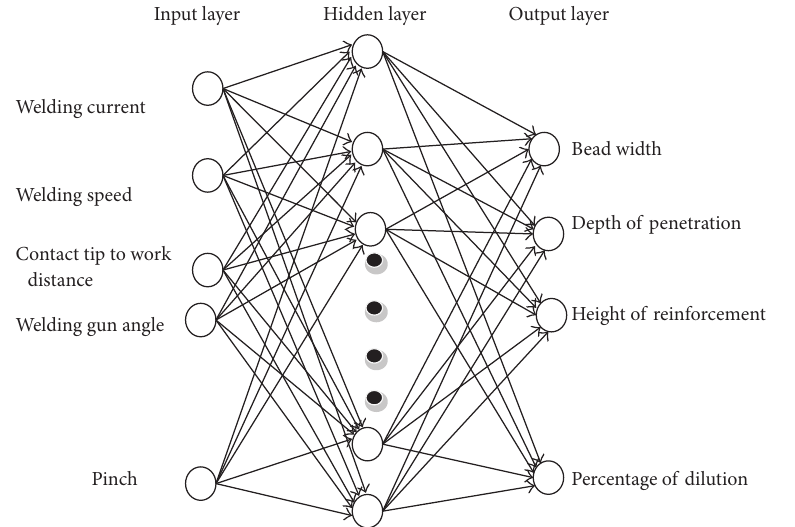
Figure 6: Neural network architecture.